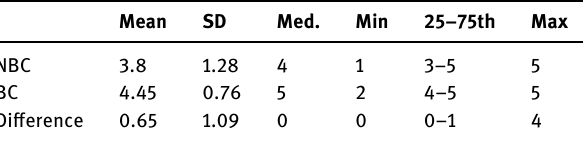
Table 9: Question 12 – Descriptives